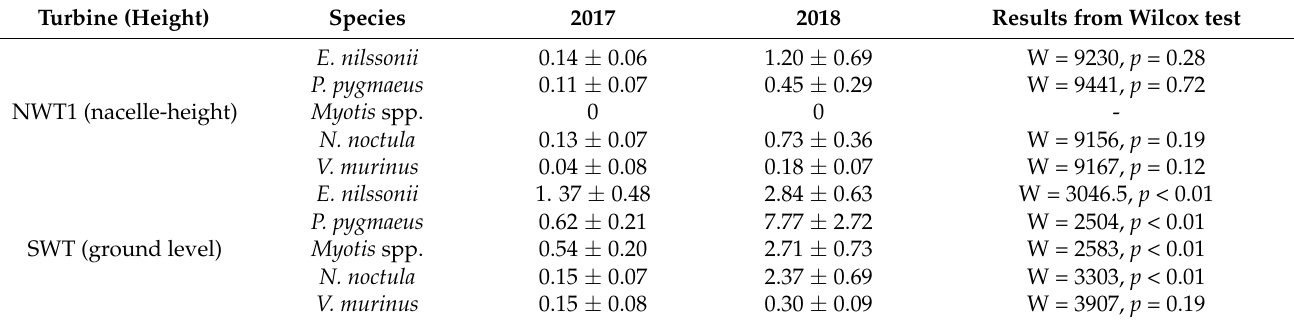
Figure 2. Relation between the total bat activity and the wind speed, temperature, and insect abundance. Results from multiple Poisson regression, where the total bat activity was the response variable. Relation, test-variable, and p -value are shown for all variables included in the model with the lowest AIC value (Table 3). The line shows the mean value for each explaining variable when the values for all the other variables in the model are kept constant at their mean value. The dark area shows 95% confidence interval. n = 87 nights. Table 4. Bat activity (number of bat passes) ± SE per night for the five most common species, recorded with Avisoft equipment, at NWT1 at nacelle-height (n = 137 nights) and at SWT at ground level (n = 91 nights) in 2017 and 2018. Results from the Wilcox test that compared the activity of each species between the two